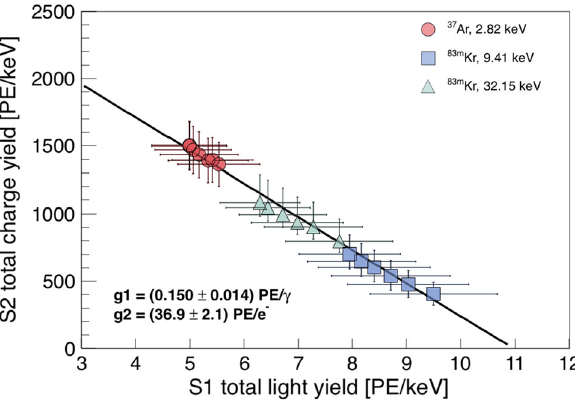
Fig. 11 Anti-correlation of ionisation and scintillation signals at dif- ferent drift fields in the range 80–968V/cm for 37 Ar and 194–968V/cm for 83m Kr,respectively.Theaxisintersectionsyieldthedetector-specific gains g 1 and g 2 from the combined energy scale